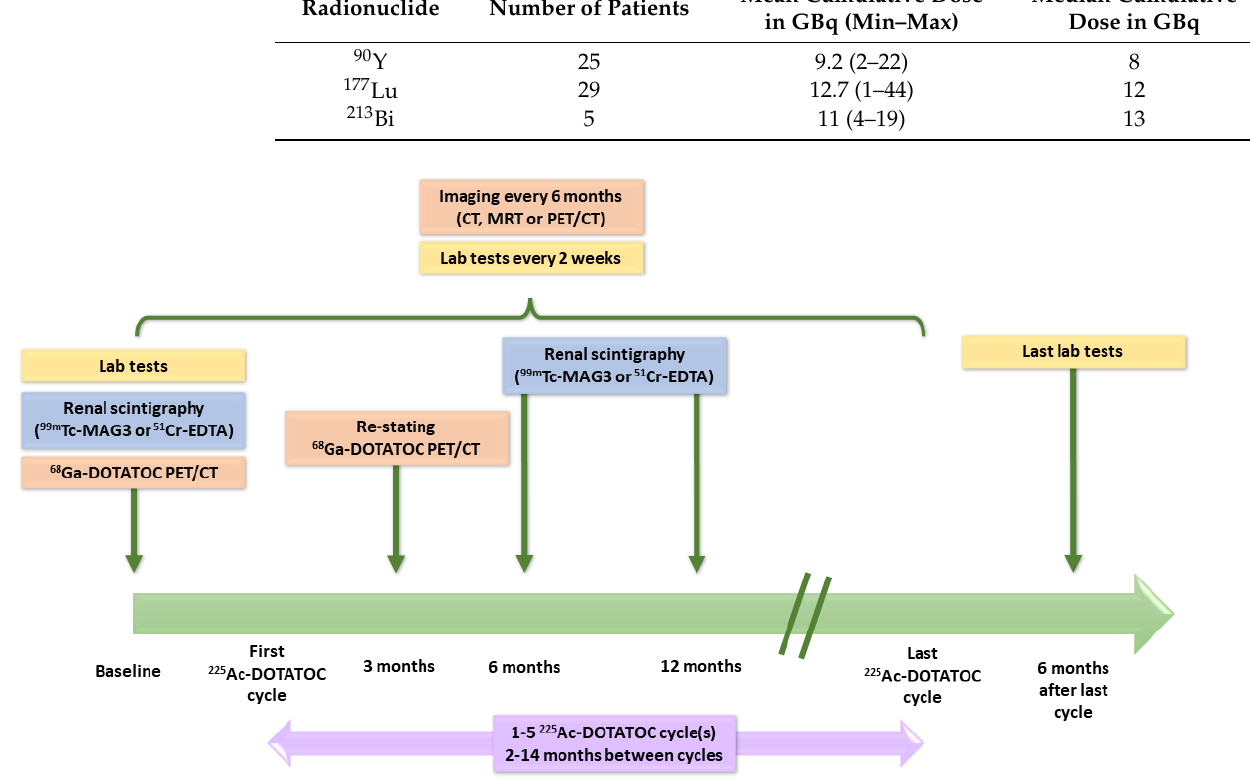
Figure 8. Course of the retrospective study reported by Kratochwil et al.